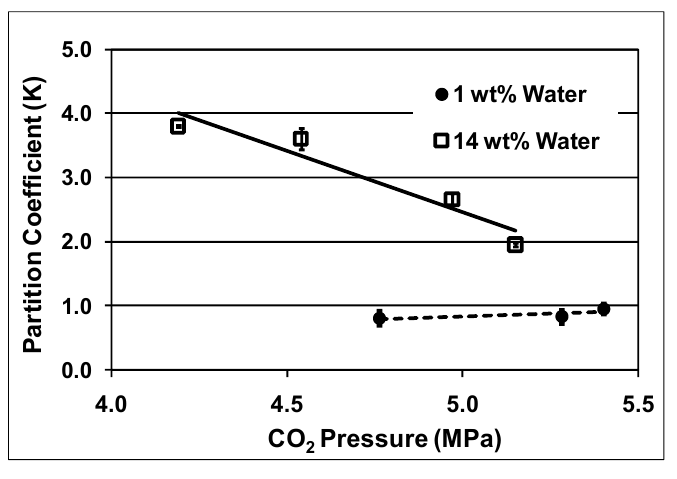
Figure 10. Partitioning of o -tolyl-3,5-xylyl ether in the PEG-rich phase as a function of CO pressure and water contents at room temperature 2